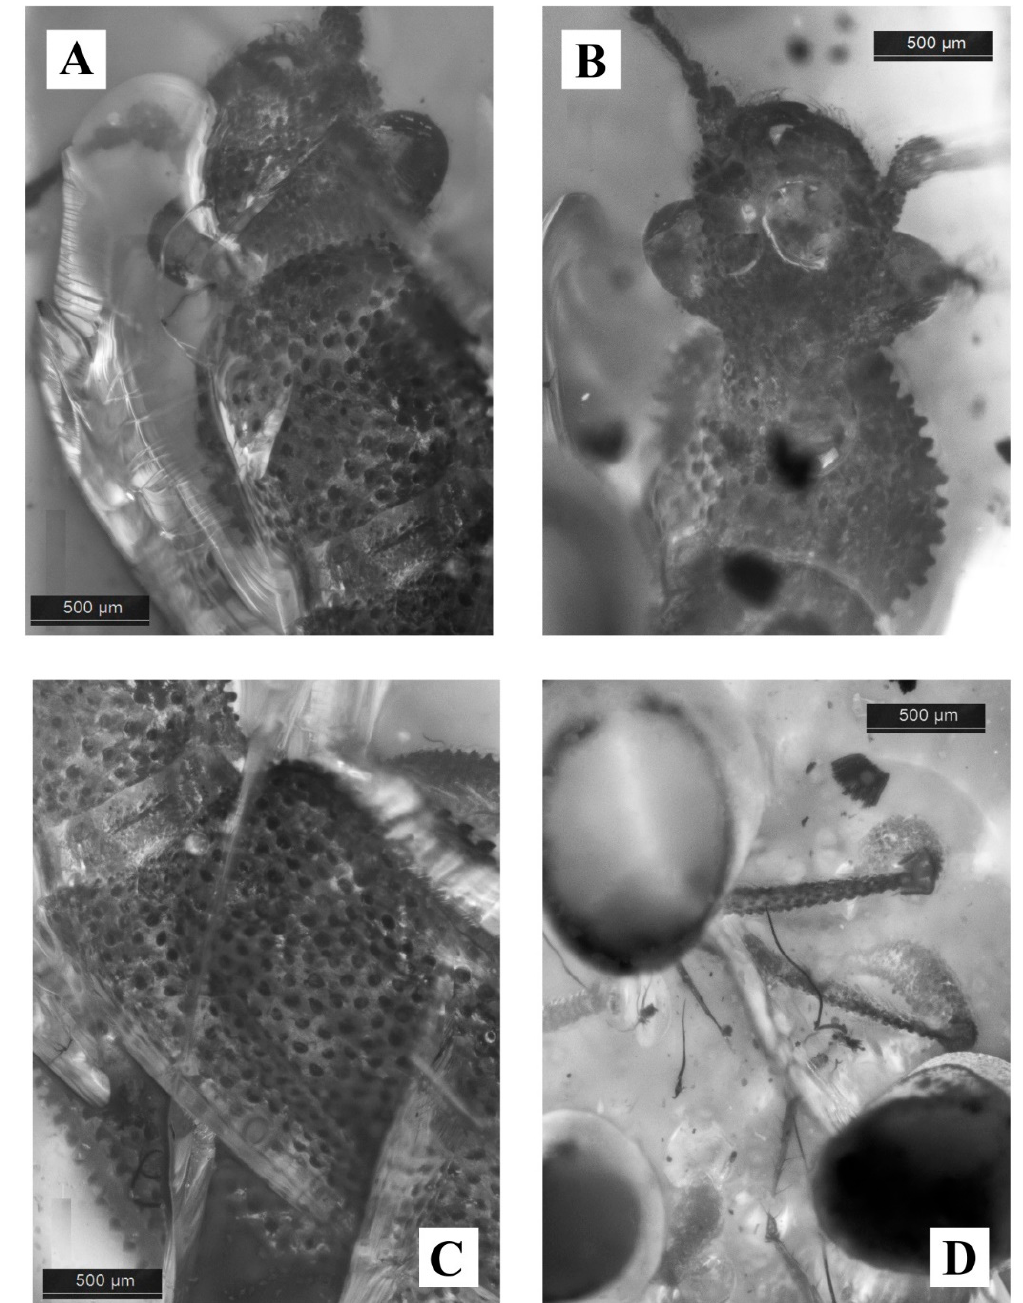
Figure 8. Ommatinae (Cupedidae): Cionocups manukyani sp. nov. , holotype GPIH 4984, coll. C. Gröhn 11,186 (Lower/Upper Cretaceous: Upper Albian/Lower Cenomanian; Myanmar, Kachin, Burmese amber); fluorescent microscopy with filter set N21: A —head and prothorax, dorsal, B —same, ventral, C —prothoracic and elytral bases, dorsal, D —intermediate and posterior legs; length of inclusion 7.3 mm; scale for each picture provided; original.